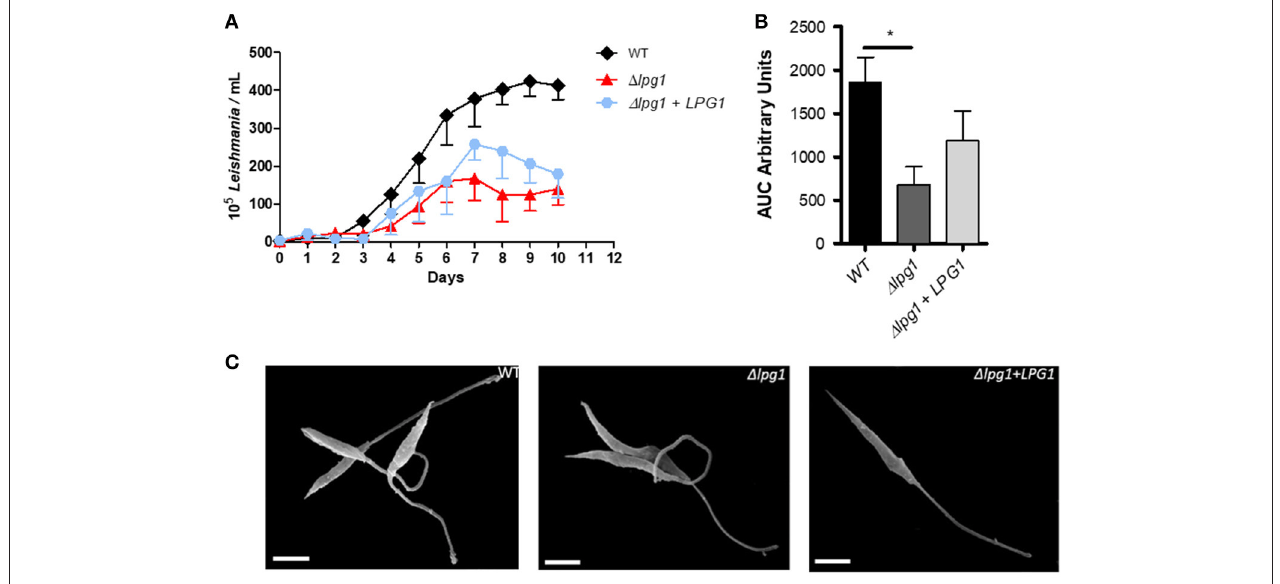
FIGURE 2 | Growth curve and morphology of the 1 lpg1 mutant. WT, 1 lpg1 and 1 lpg1 + LPG1 parasites were cultured at initial concentrations of 1 × 10 5 /ml in HOMEM medium. (A) Axenic growth curve of late log-phase WT, 1 lpg1 and 1 lpg1 + LPG1 parasites, as showed by the area under the curve (AUC) (B) . The number of viable parasites was evaluated by direct counting. Each point represents mean and SE. Data are representative of at least three independent assays and were collected in triplicate for each condition. * p < 0.05. (C) Parasites were processed for scanning electron microscopy (SEM) and photographed under a JEOL JSM-6390LV microscope at 6000x magnification (C) . Scale bar, 2 µ m.